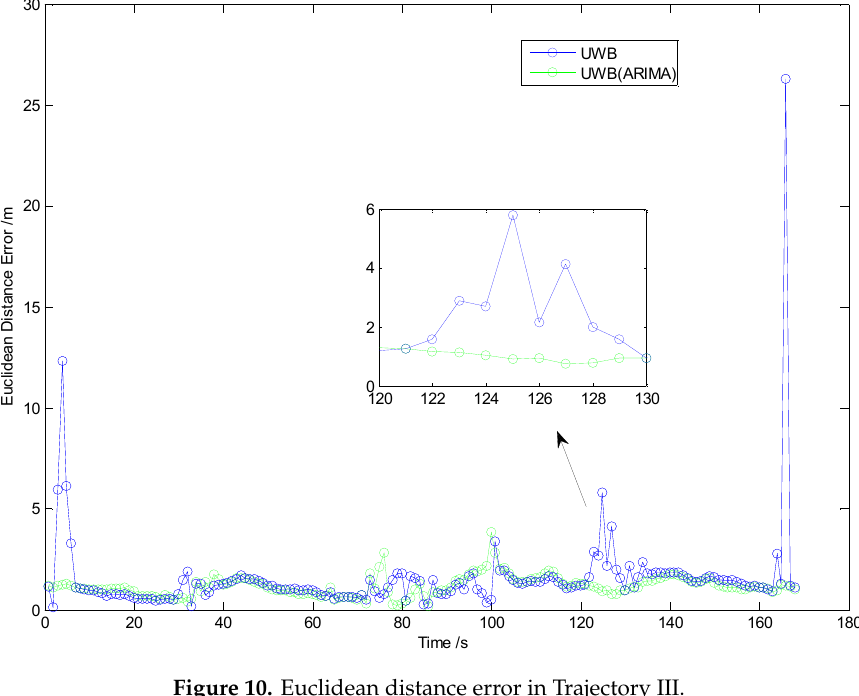
Figure 10. Euclidean distance error in Trajectory III. Table 3. Statistics of Euclidean Distance Errors in Trajectory III (m).